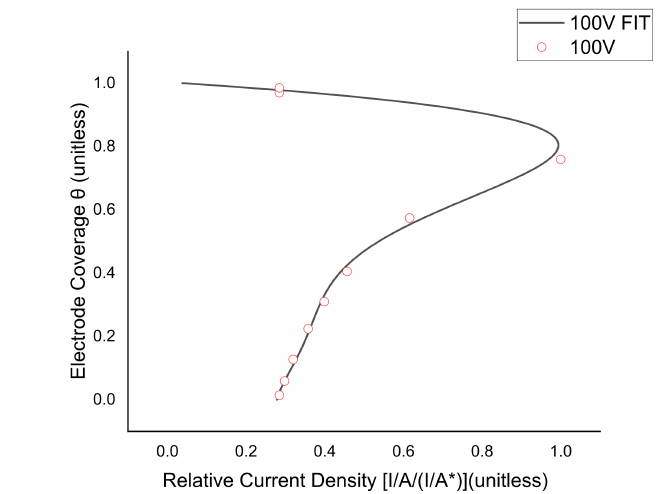
Figure 9. Theoretical and simulated variations of current density in the surface of the electrode for 100 V treatment (2 KV/cm Electric field). I/A = Actual current density; I/A* = Maximum current density; Θ = Electrode coverage